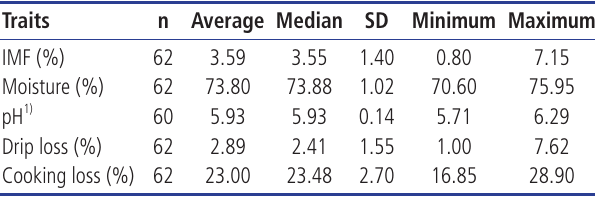
Table 1. Summary of pork loin quality traits Traits